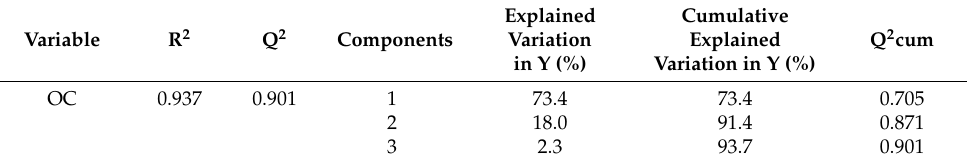
Table 2. Summary of PLSR model outputs relating to soil OC content in natural coastal areas. Variable